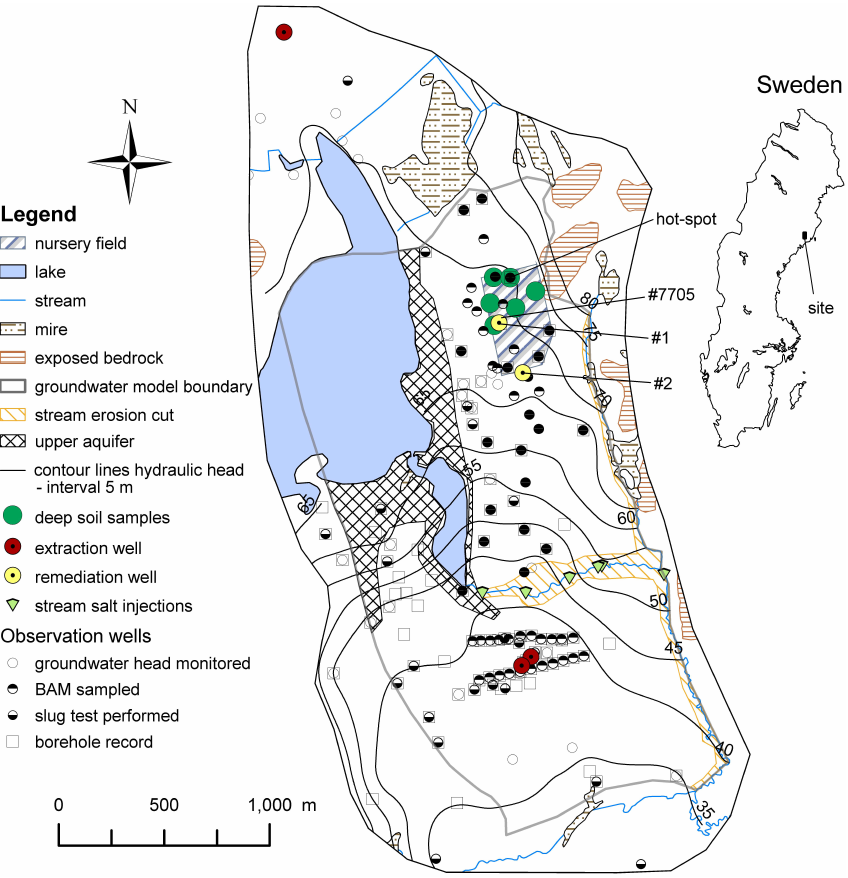
Fig. 2. Location of the site within Sweden and map showing location of the nursery site in the modeled area, observation wells, extraction wells, deep soil samples, and salt injections. The contour lines of the hydraulic head are drawn every 5m, and lakes, streams, erosion cuts, mires and exposed bedrock are represented. #7705 refers to an observation well; #1 and #2 to remediation